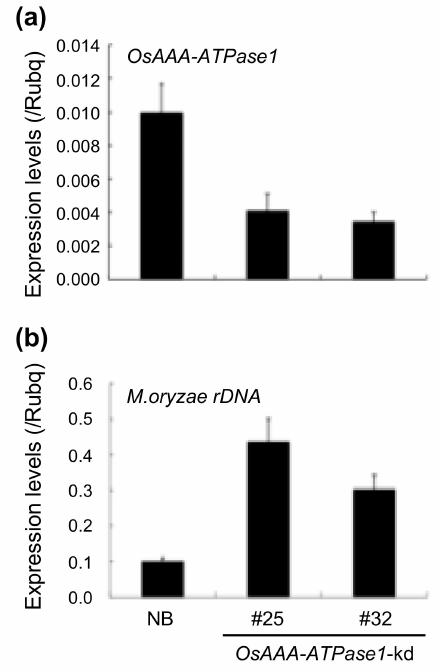
Figure 5. Compromised blast resistance in OsAAA-ATPase1 -kd plants (#25 and #32). ( a ) Expression of OsAAA-ATPase1 . ( b ) Relative fungal growth ( M. oryzae rDNA ) in Nipponbare (NB) and OsAAA-ATPase1 -kd lines (#25 and #32) respectively. Data are represented as means ± SDs.